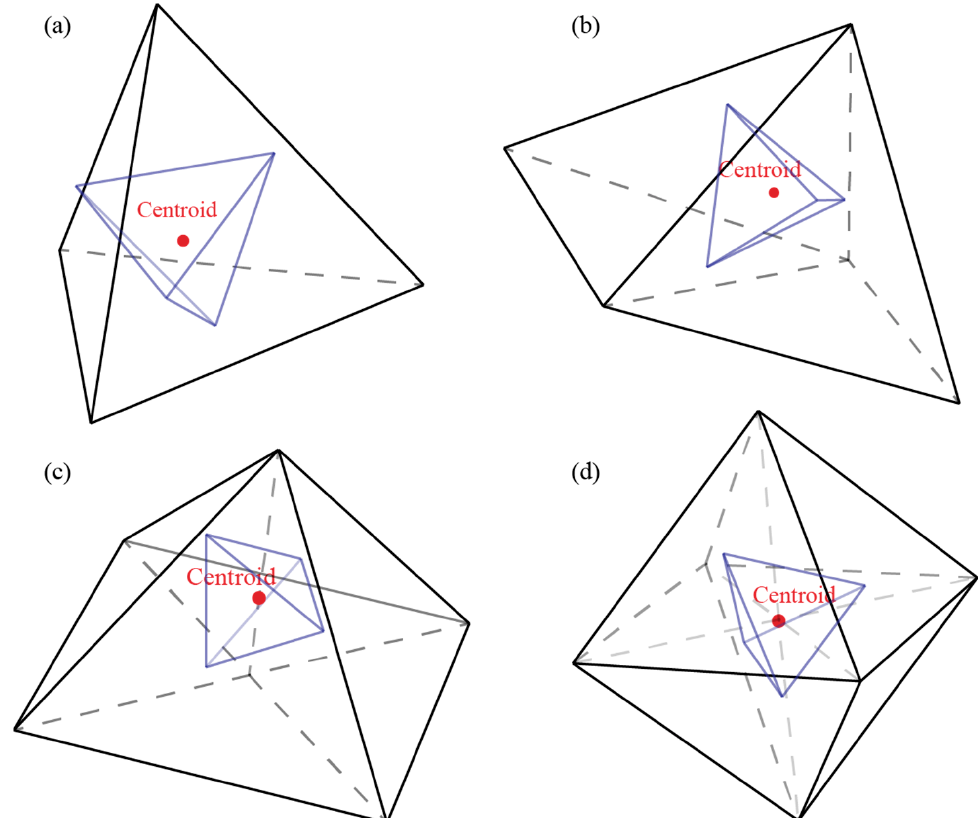
Figure 2. Schematic diagram of attribute mapping. The coarse mesh is in black, while the fine mesh is in blue. The centroid of the fi ne mesh is ( a ) within a coarse mesh, ( b ) on the surface shared by two coarse meshes, ( c ) at the edge shared by several coarse meshes, and ( d ) at the vertex shared by sev- eral coarse meshes.